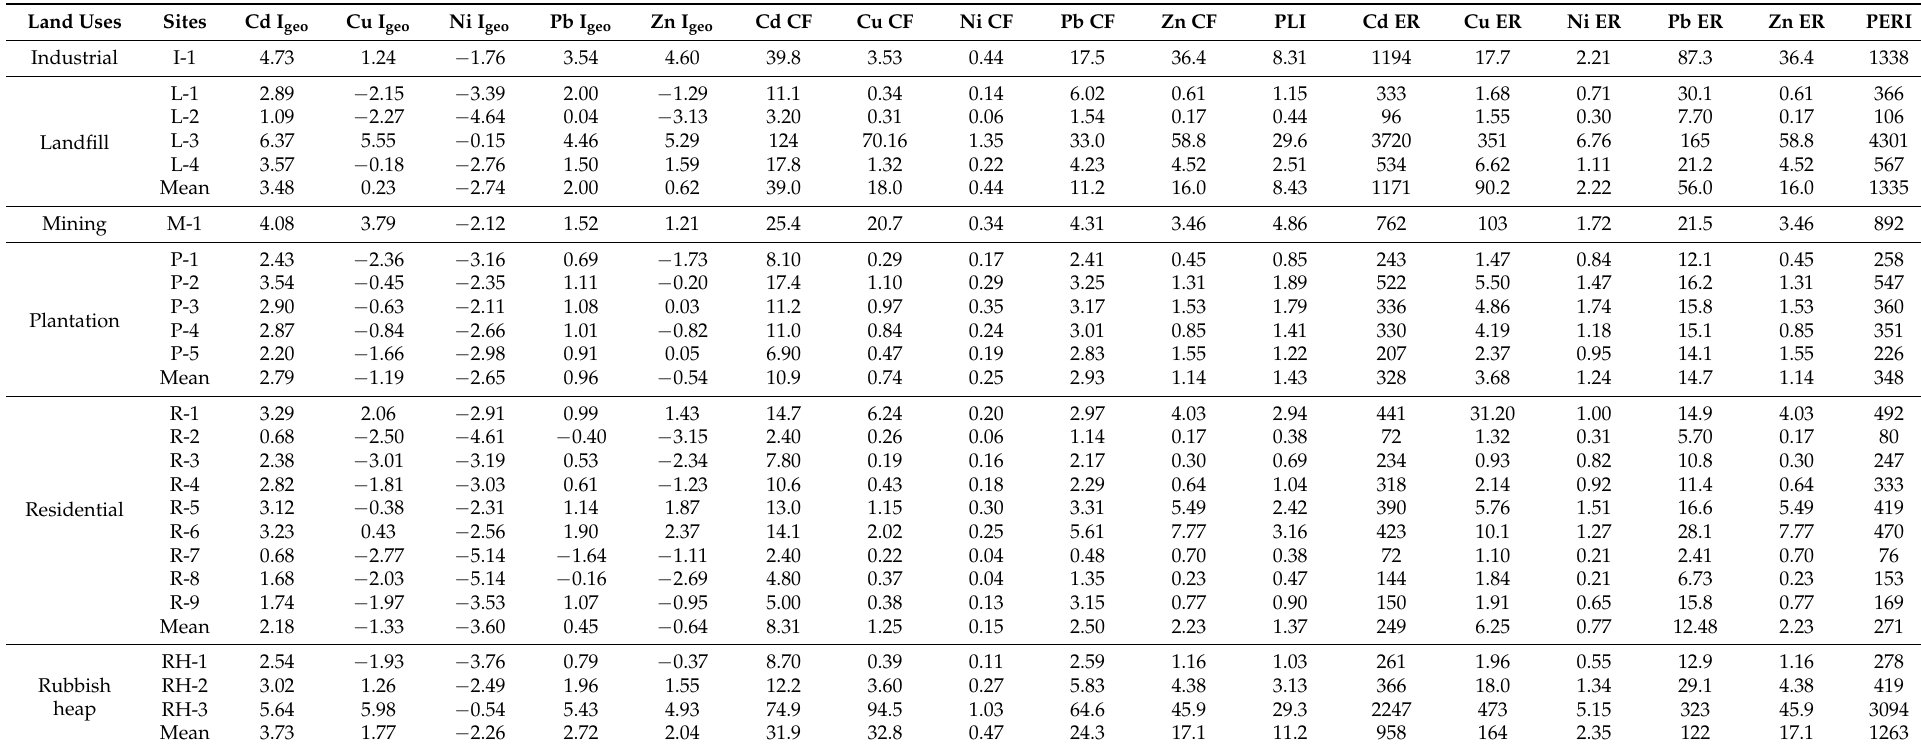
Table 5. Values of geoaccumulation index (I geo ), contamination factor (CF), pollution load index (PLI), ecological risk (ER) for Cd, Cu, Ni, Pb, and Zn, and potentially ecological risk index (PERI) of topsoils collected from different land uses in Peninsular Malaysia